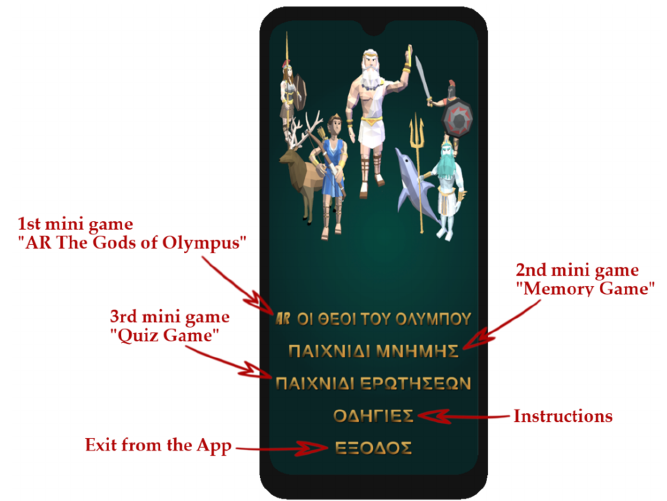
Figure 1. The start screen of the game.